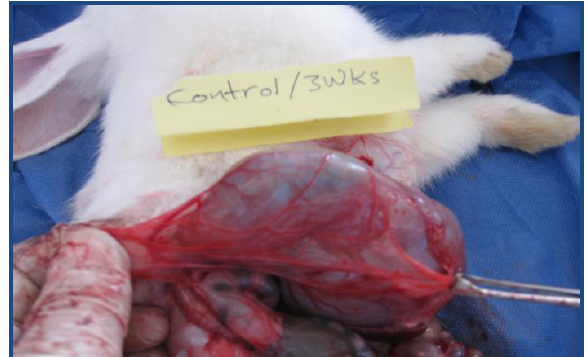
Figure, 3: Gross photograph of a rabbit of G1, at the 21st P.O. day. Showing a wide loosely attached omental adhesion extends from abdominal wall to the stomach.